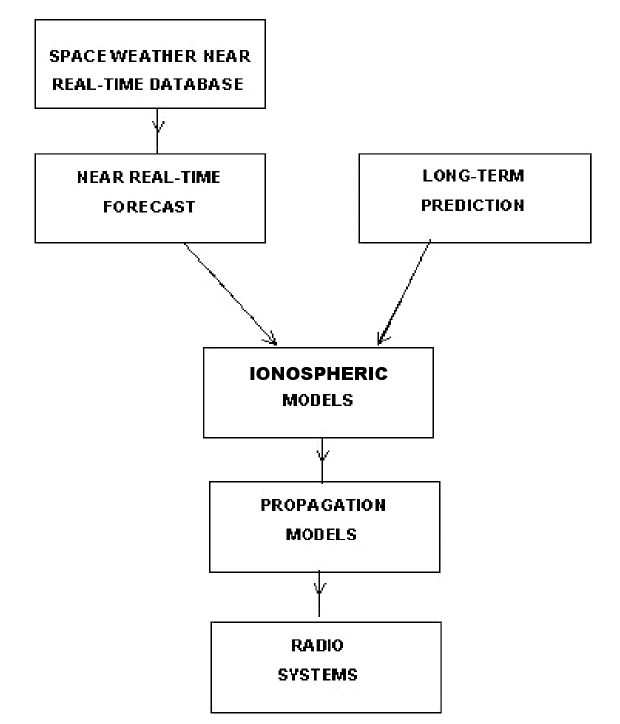
Fig. 1.1. Chart showing the chain of dependence of radio-system performance on space weather (Bradley,